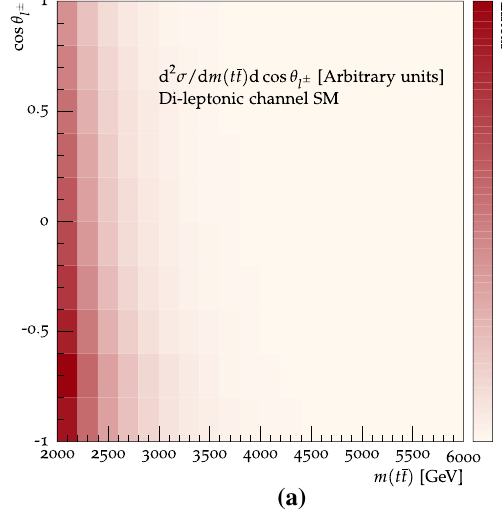
Fig. 4 Two-dimensional shape distributions of m ( t ¯ t ) and cos θ l ± for the expected SM background ( a ) and a narrow ( c = 1) G 1 ( b ) in the di- leptonic analysis. This corresponds to one of the best scenarios among